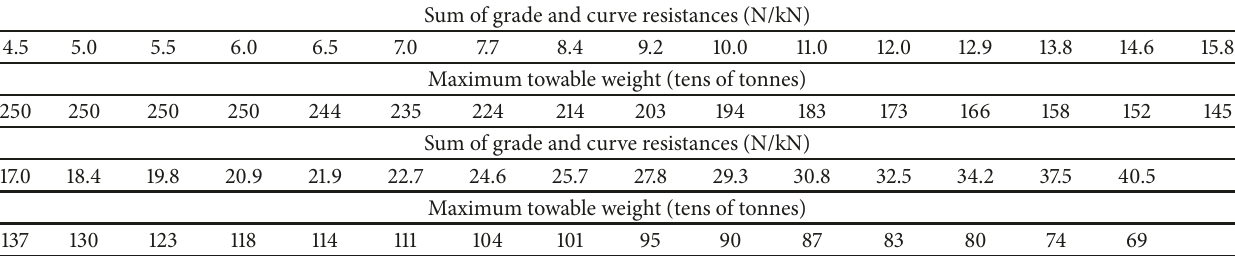
Table 4: Maximum towable weight, fulfilling the resistance of train couplers according to RFI (Italian) rules, expressed in tens of tonnes, versus the sum of grade and curve resistances, expressed in